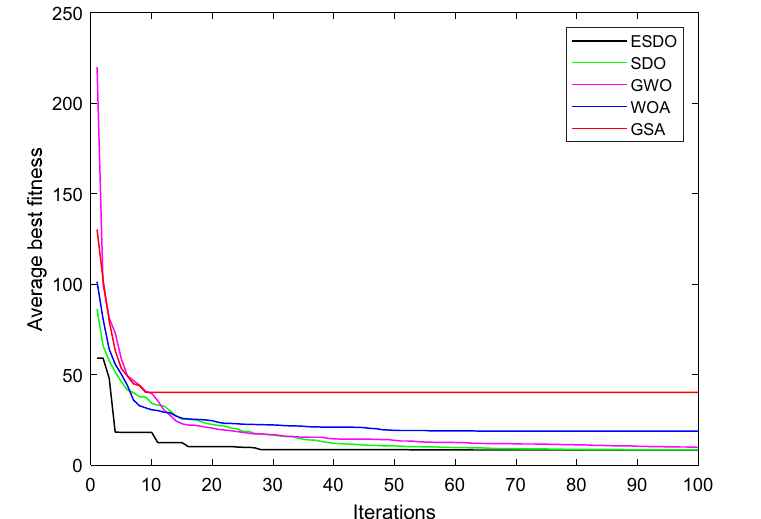
Figure 18. Convergence curves of average fitness with 16% load.